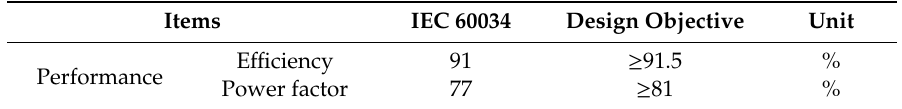
Table 3. International Electrotechnical Committee (IEC) 60034 standard and design objective of the e ffi ciency and power factor.